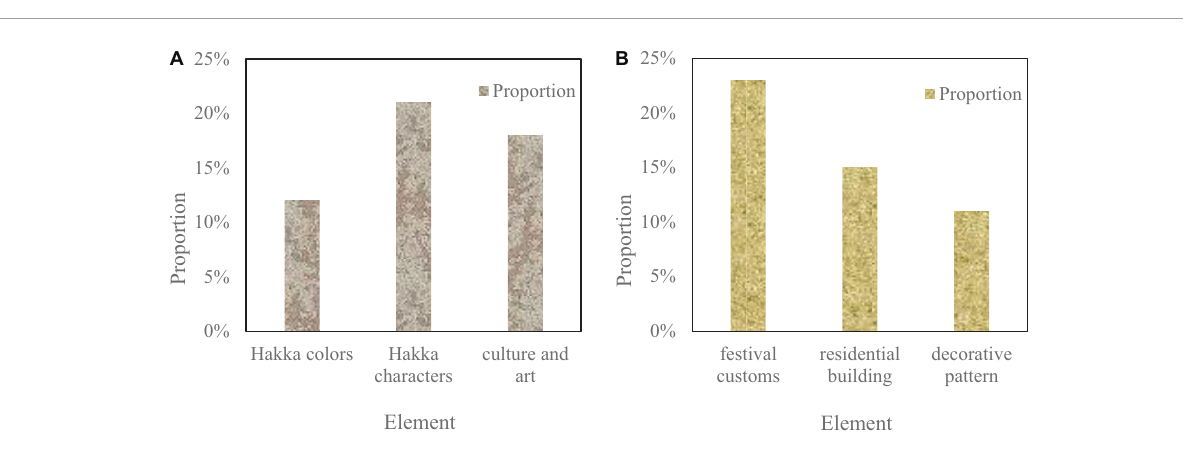
FIGURE9 Distribution of visual symbols in Hakka cultural brand image. (A) Shows that the proportion of Hakka colors is 12%, and the proportion of Hakka characters is 21%. (B) Shows that the proportion of festival customs is 23%, the proportion of residential buildings is 15%, and the proportion of decorative patterns is 11%. The proportion of solar terms and customs visual symbols is the highest, indicating that this design attaches great importance to solar terms and customs. In addition, although the proportions of different visual symbols are different, they are not very different, indicating that this design has considered different visual symbols of Hakka culture, which also expresses the comprehensiveness of this